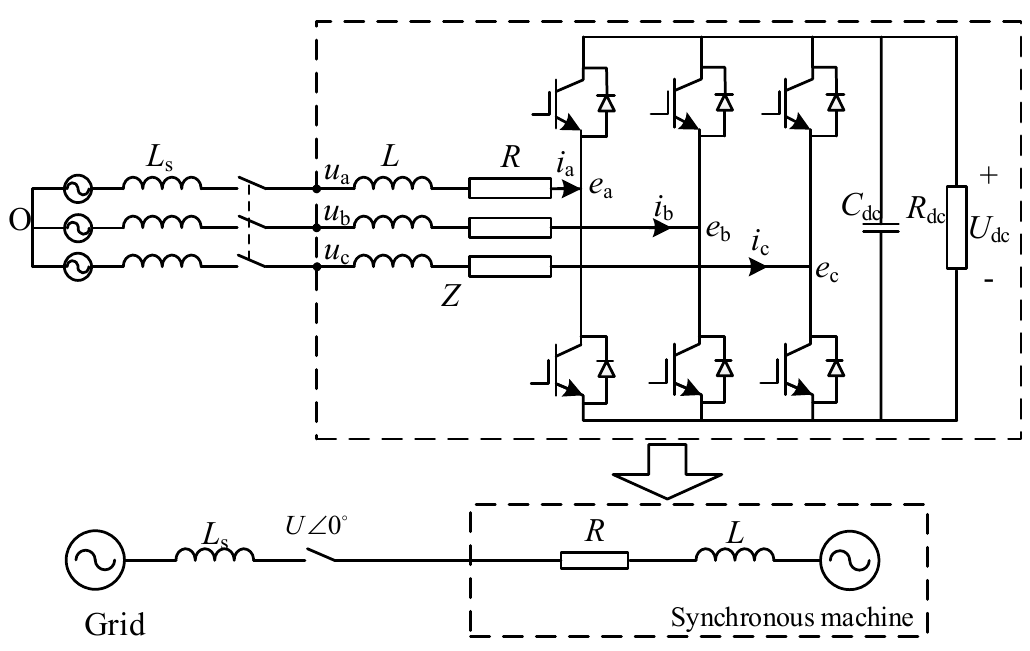
Figure 1. Topology of the three ‐ phase rectifier.